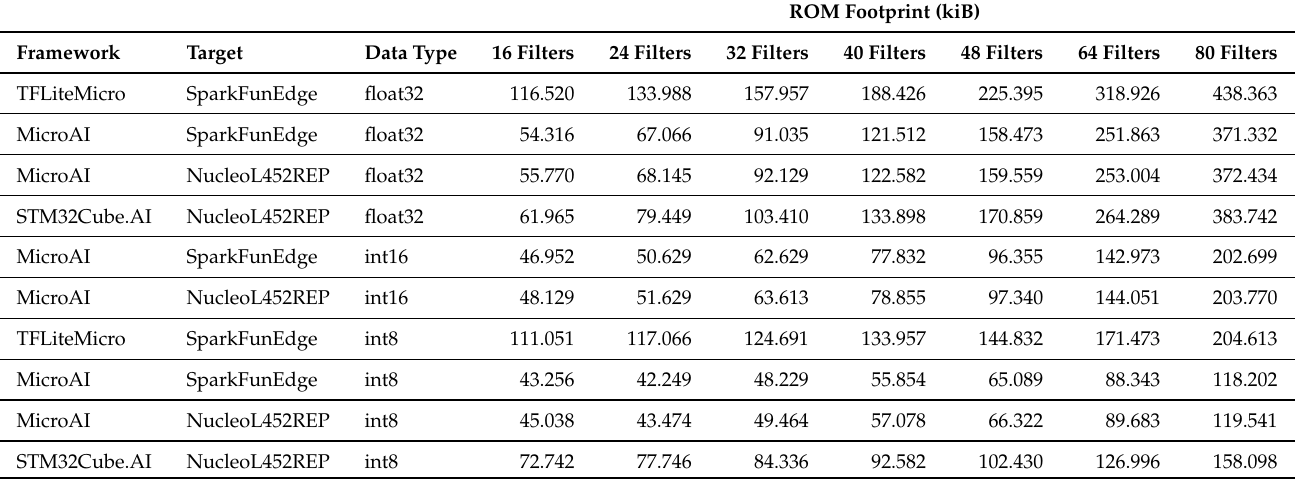
Table A3. ROM footprint vs. filters for TFLite Micro, STM32Cube.AI and MicroAI.